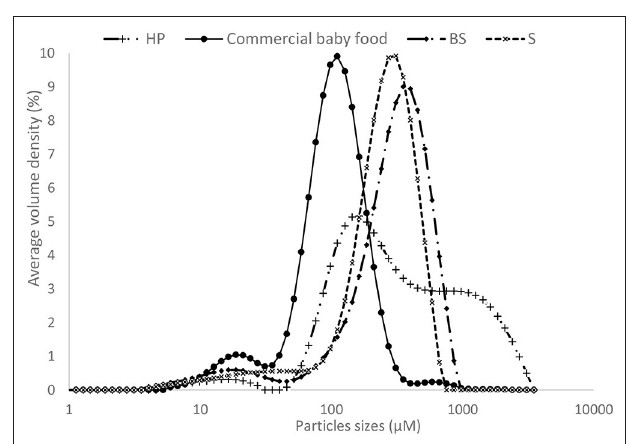
FIGURE 4 | Particle size distribution of the different processed OFSP